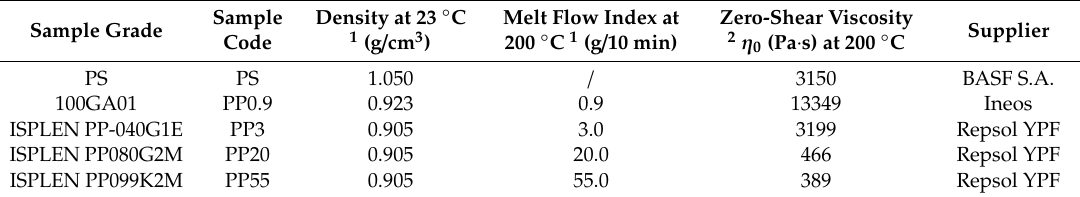
Table 1. Sample codes and characteristics of polystyrene (PS) used as a matrix phase and isotactic polypropylene (iPP) used as the dispersed